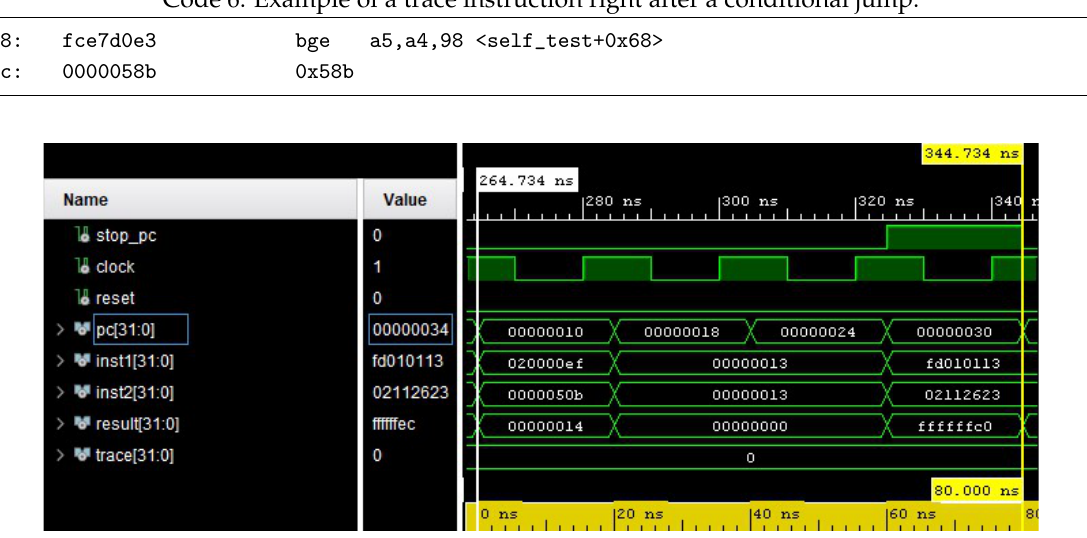
Figure 10. Execution results of a pair composed of an unconditional jump (0x10) and a trace instruction (0x14). In the first cycle, the jump is executed, and the trace instruction is invalidated. At the following two cycles, NOP instructions are executed due to the unconditional jump. In addition, in the last cycle, the jump’s target instruction (0x30) is